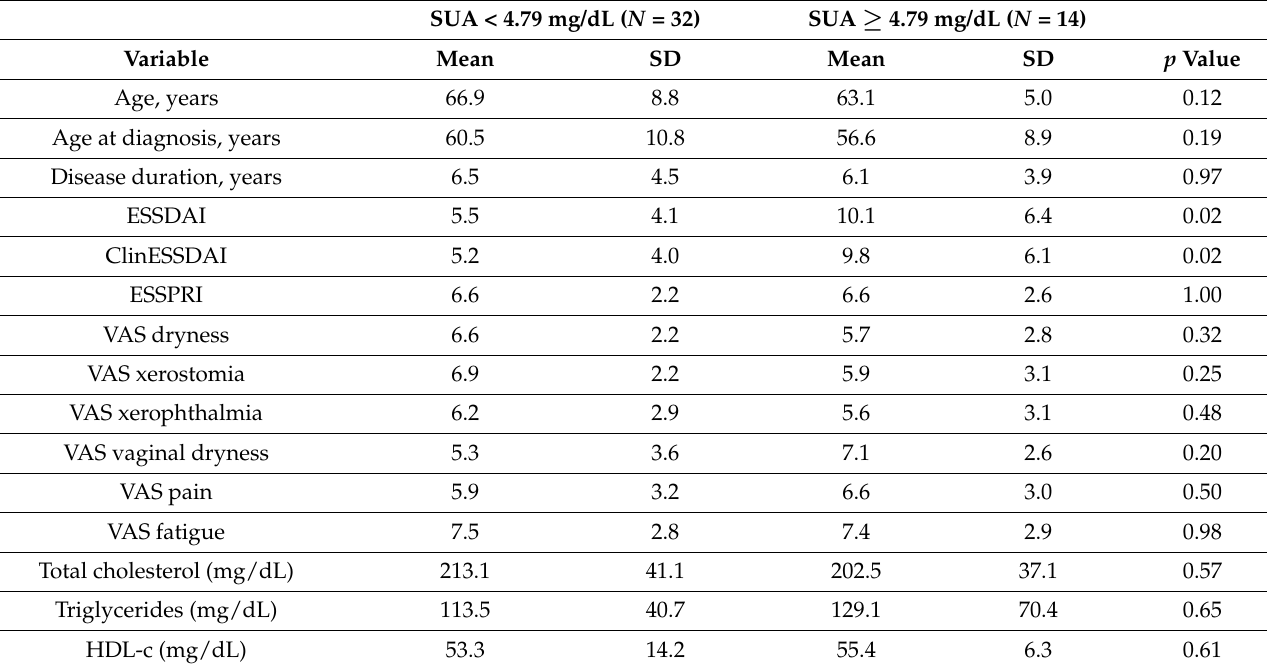
Table 4. Characteristics of hypertensive patients ( N = 46) according to serum uric acid